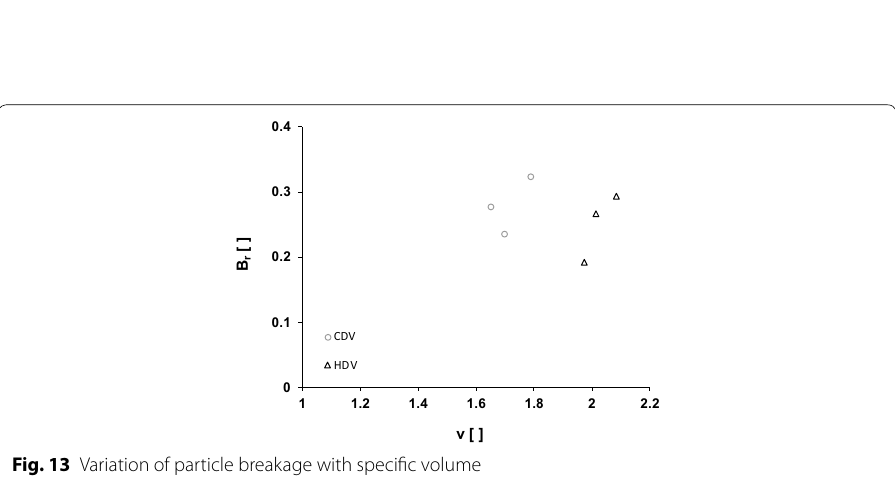
Fig. 12 Change in grading resulting from particle breakage after compression for the CDV